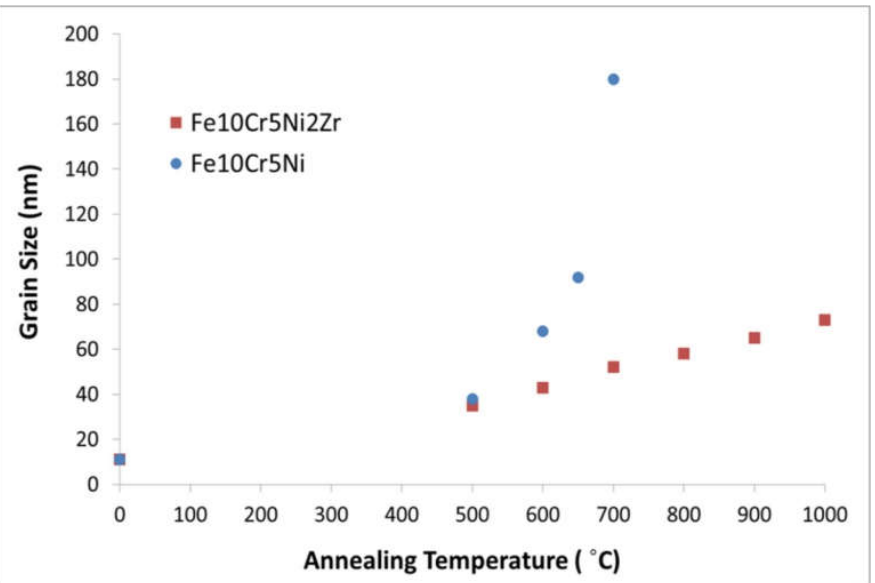
Figure 7. Grain growth of Fe-10Cr-5Ni alloys with and without Zr, after annealing for 1 h at differ- ent temperatures. [33, reproduced with copyright clearance]. temperatures [33], reproduced with copyright